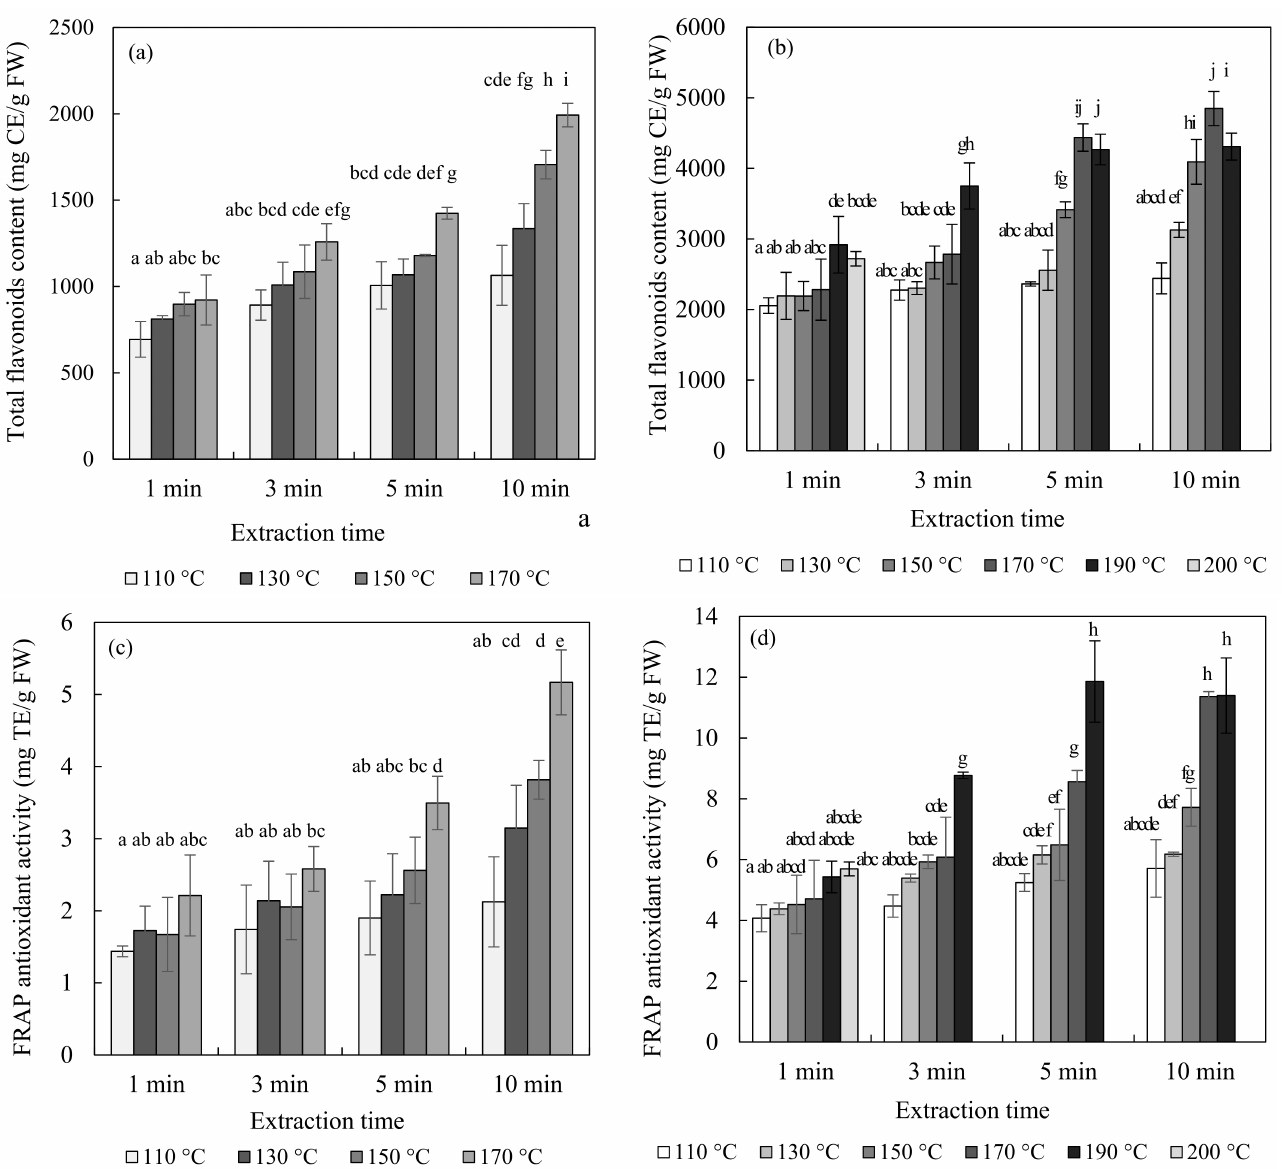
Figure 4. Total flavonoid content and ferric-reducing antioxidant power (FRAP) antioxidant activity of blueberry ( a , c ), and chokeberry ( b , d ) extracts according to the extraction time and temperature in subcritical-water extraction (SWE) ( n = 3). TE (trolox equivalent), FW (fresh weight), CE (catechin equivalent). Means in bars with same letters are not significantly different according to Duncan’s test at p <